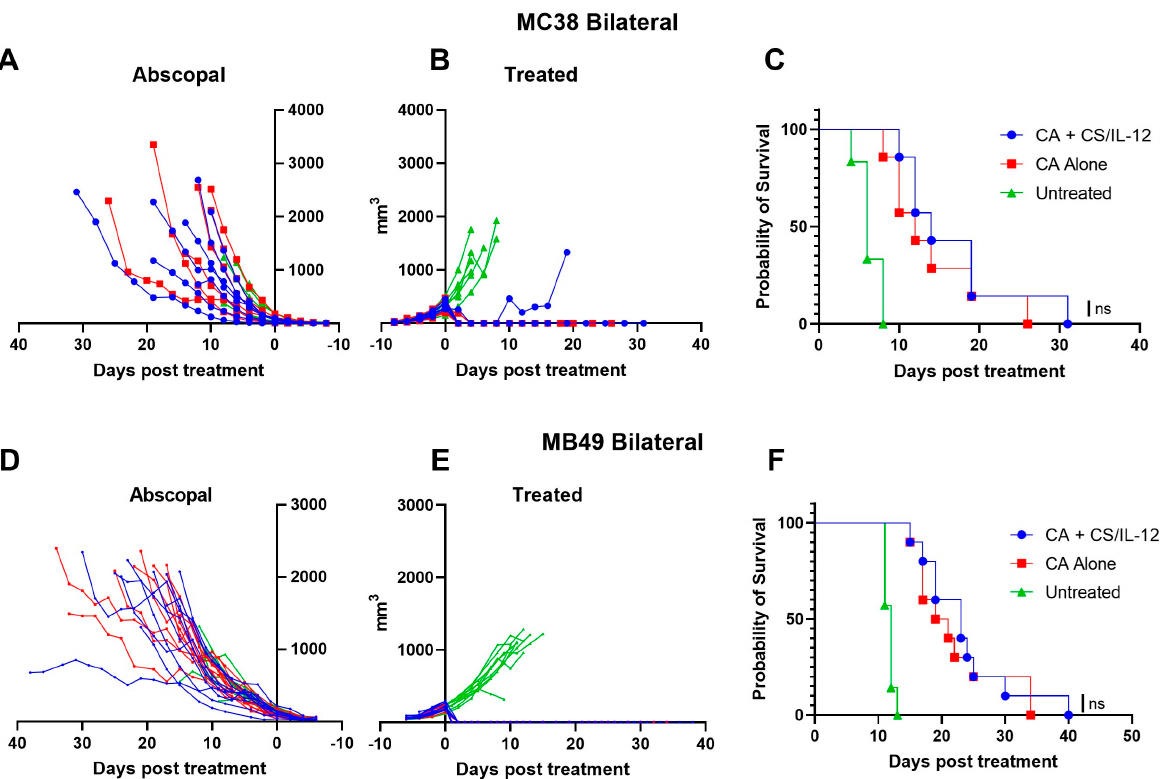
Figure 4. Addition of CS/IL-12 to CA does not slow established abscopal tumor growth. In both the MC38 (n = 8) and MB49 (n = 10) models, 3 × 10 5 and 1.5 × 10 5 cells were subcutaneously implanted on the right and left fl anks, respectively. The larger of the two tumors was treated with CA alone or CA + CS/IL-12, administered immediately post-CA, upon reaching 150–500 mm 3 . Individual tumor volumes on untreated ( A , D ) and untreated ( B , E ) sides were measured and survival ( C , F ) was monitored. Statistical signi fi cance was calculated using the Log-rank (Mantel–Cox) test ( C , F ). ns— not signi fi cant.